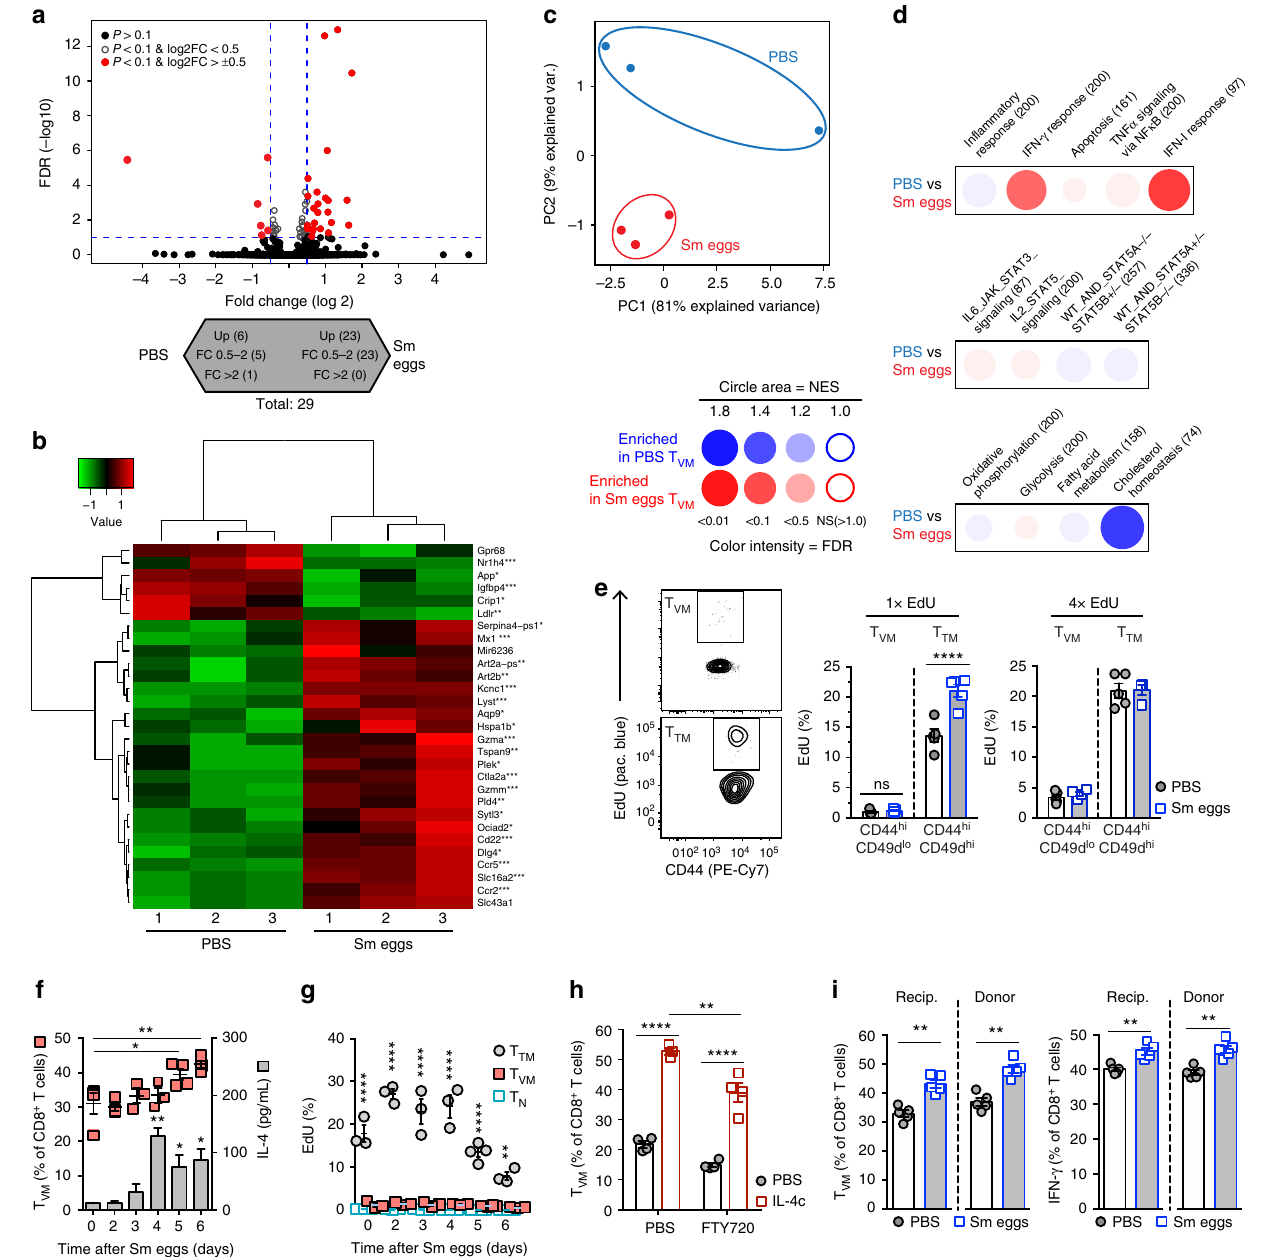
Fig. 6 Phenotypic changes in helminth-driven T VM cells. a – d Transcriptomics analysis of FACsorted spleen T VM treated as in Supplementary Figure 1a. a Differentially expressed (DE) genes ( P < 0.1) in red in volcano plot, and showing in the arrowheads the direction of upregulated expression. b Heatmap of DE genes ( P < 0.1, DE over 1.5-fold). Left margin shows hierarchical clustering and right annotation indicate gene symbols. c Principal-component analysis. d Enrichment for selected hallmark gene-sets from the MSigDB by gene-set enrichment analysis with BubbleGUM. WT_AND_STAT5A − / − _STAT5B + / − and WT_AND_STAT5A − / − _STAT5B + / − gene-sets were obtained from published data 60 . Key color indicates cell subset showing enrichment for the gene set, and size of symbols and color intensity indicate signi fi cance of enrichment (surface area proportional to absolute value of the normalized enrichment score (NES); color intensity indicates the false-discovery rate (FDR)). Numbers in parentheses (above) indicate number of genes. NS not signi fi cant. e EdU incorporation in CXCR3 hi CD49d lo T VM and CD49d hi T TM cells after Sm egg treatment as outlined in Supplementary Figure 1a. 1 × EdU, injection 4 h before harvest; 4 × EdU, injection at days 18, 19, 20, and 21 after Sm egg i.p. injection. f Percentages of spleen T VM cells after Sm egg injection i.p. and IL-4 levels after SEA restimulation of splenocytes at the indicated time points. g Percentage of spleen EdU + T TM , T VM , or T N cells at the indicated time points after Sm egg injection i.p. h Percentages of spleen T VM cells after IL-4c treatment in mice treated daily with FTY720. i Spleen CD8 + T cells were adoptively transferred to congenic mice before injection of Sm eggs i.p. At 7 days, percentages of recipient or donor spleen T VM cells and IFN- γ -producing cells upon restimulation in the spleen are shown in CD45.1.2 + recipient or CD45.1 + donor CD8 + T cells. Statistical signi fi cance calculated using two-way analysis of variance (ANOVA) and Sidak ’ s multiple-comparison test ( * P < 0.05, ** P < 0.01, *** P < 0.001, **** P < 0.0001). Data are representative of two independent experiments with three to fi ve mice per group (mean ± s.e.m. in e, f and results from individual mouse are